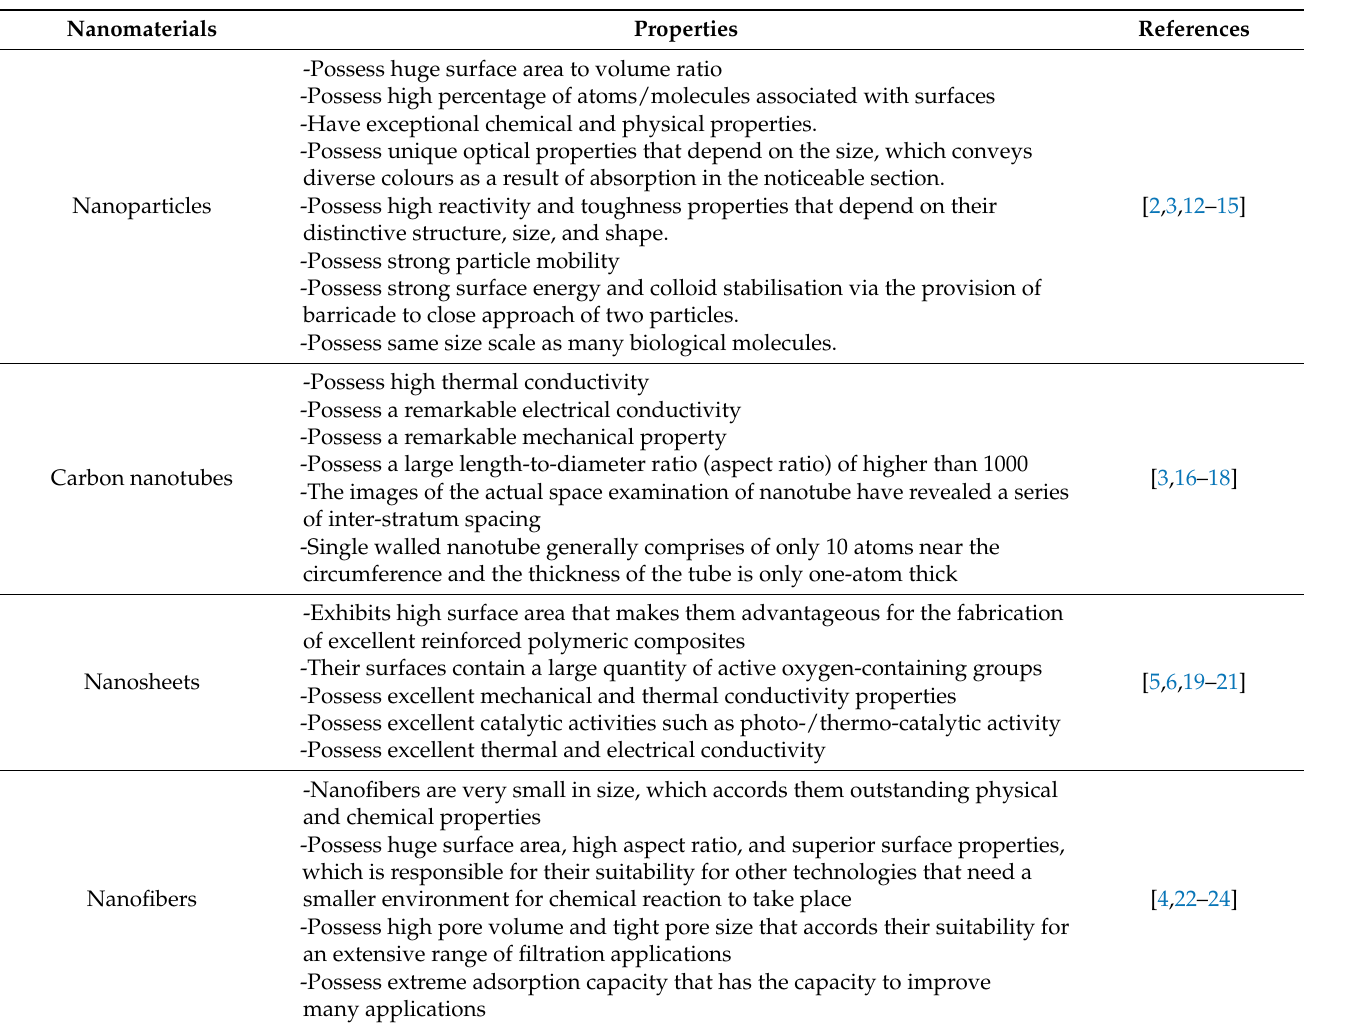
Table 1. Exceptional properties of different